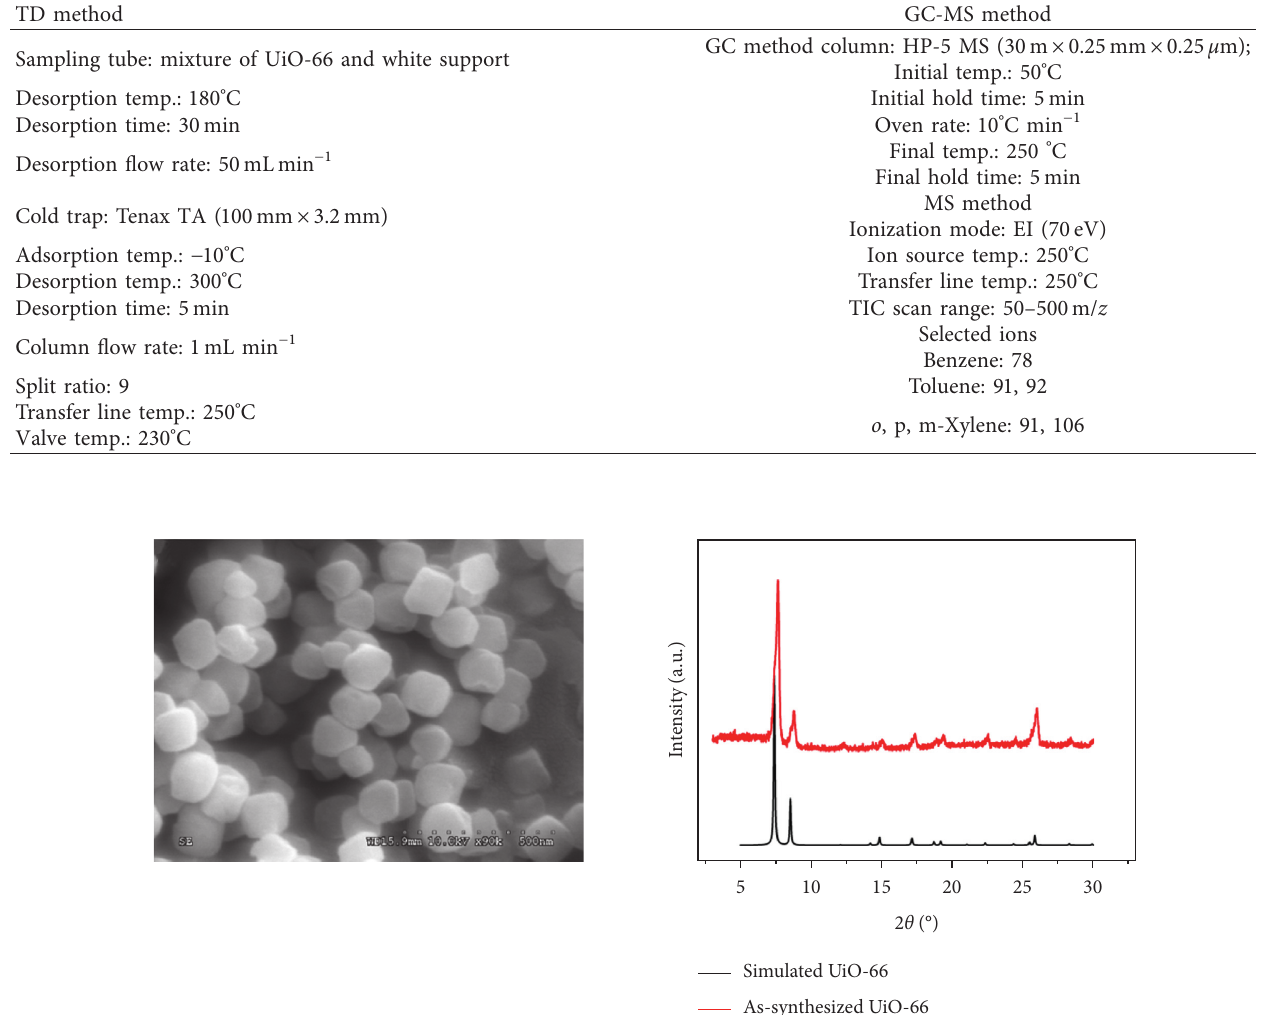
Table 1: Operating conditions of TD-GC-MS for BTX analysis.